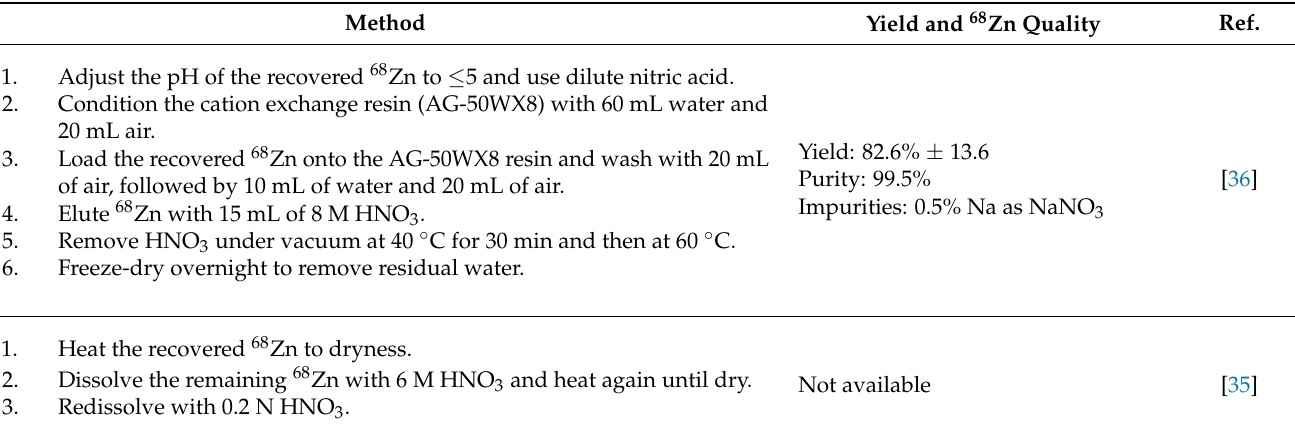
Table 9. Method, yield, and 68 Zn quality of 68 Zn target reprocessing.